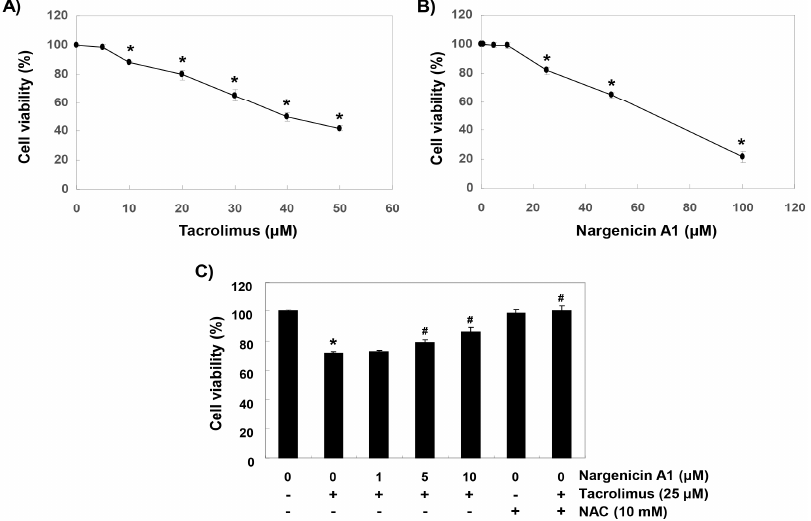
Figure 1. Protective effects of nargenicin A1 against tacrolimus-induced cytotoxicity in hirame natural embryo (HINAE) cells. Cells were treated with various concentrations of tacrolimus or